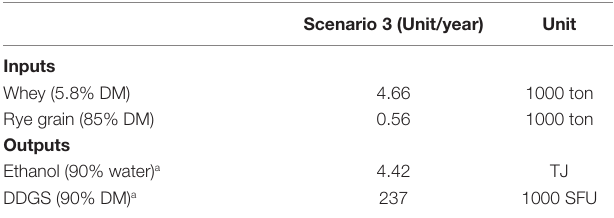
TaBle 8 | inputs and outputs from the bioethanol production process for the entire system of 1000 ha.